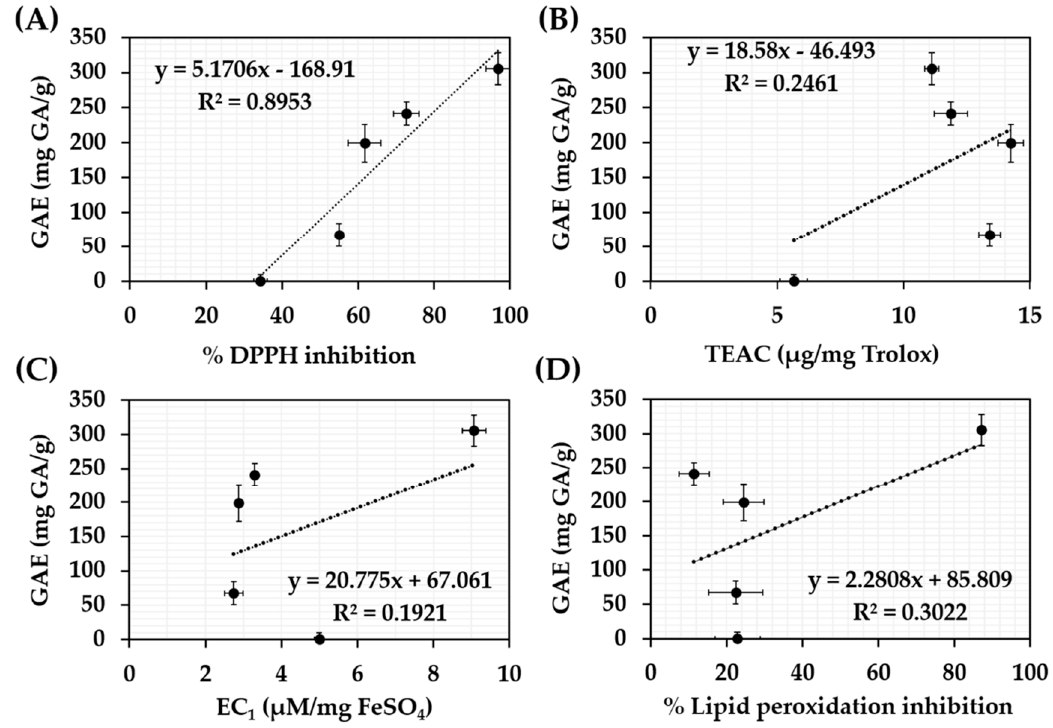
Figure 2. Correlations between total phenolics content and antioxidant activities of C. militaris extracts